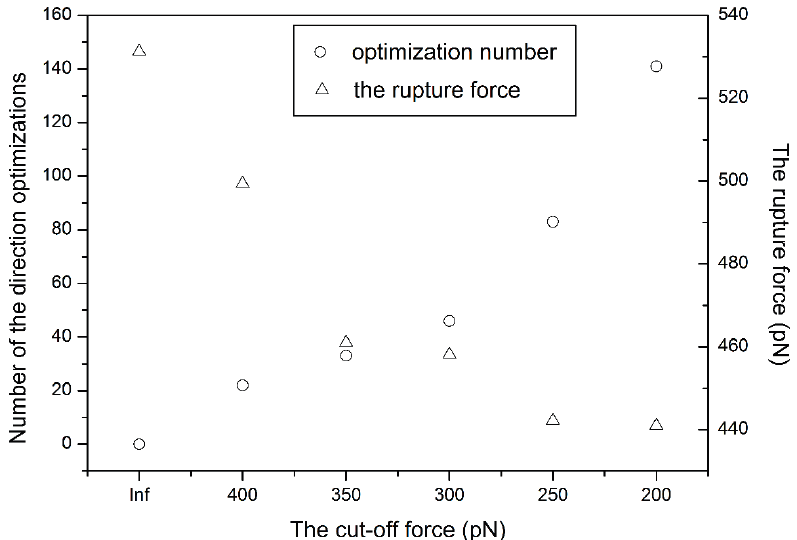
Figure 2. The influence of the cut-off force on the rupture force of